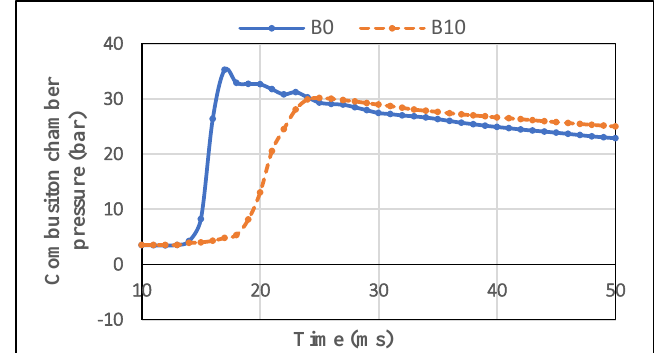
Figure 7. Pressure evolution of test fuel in the CVCC combustion chamber.